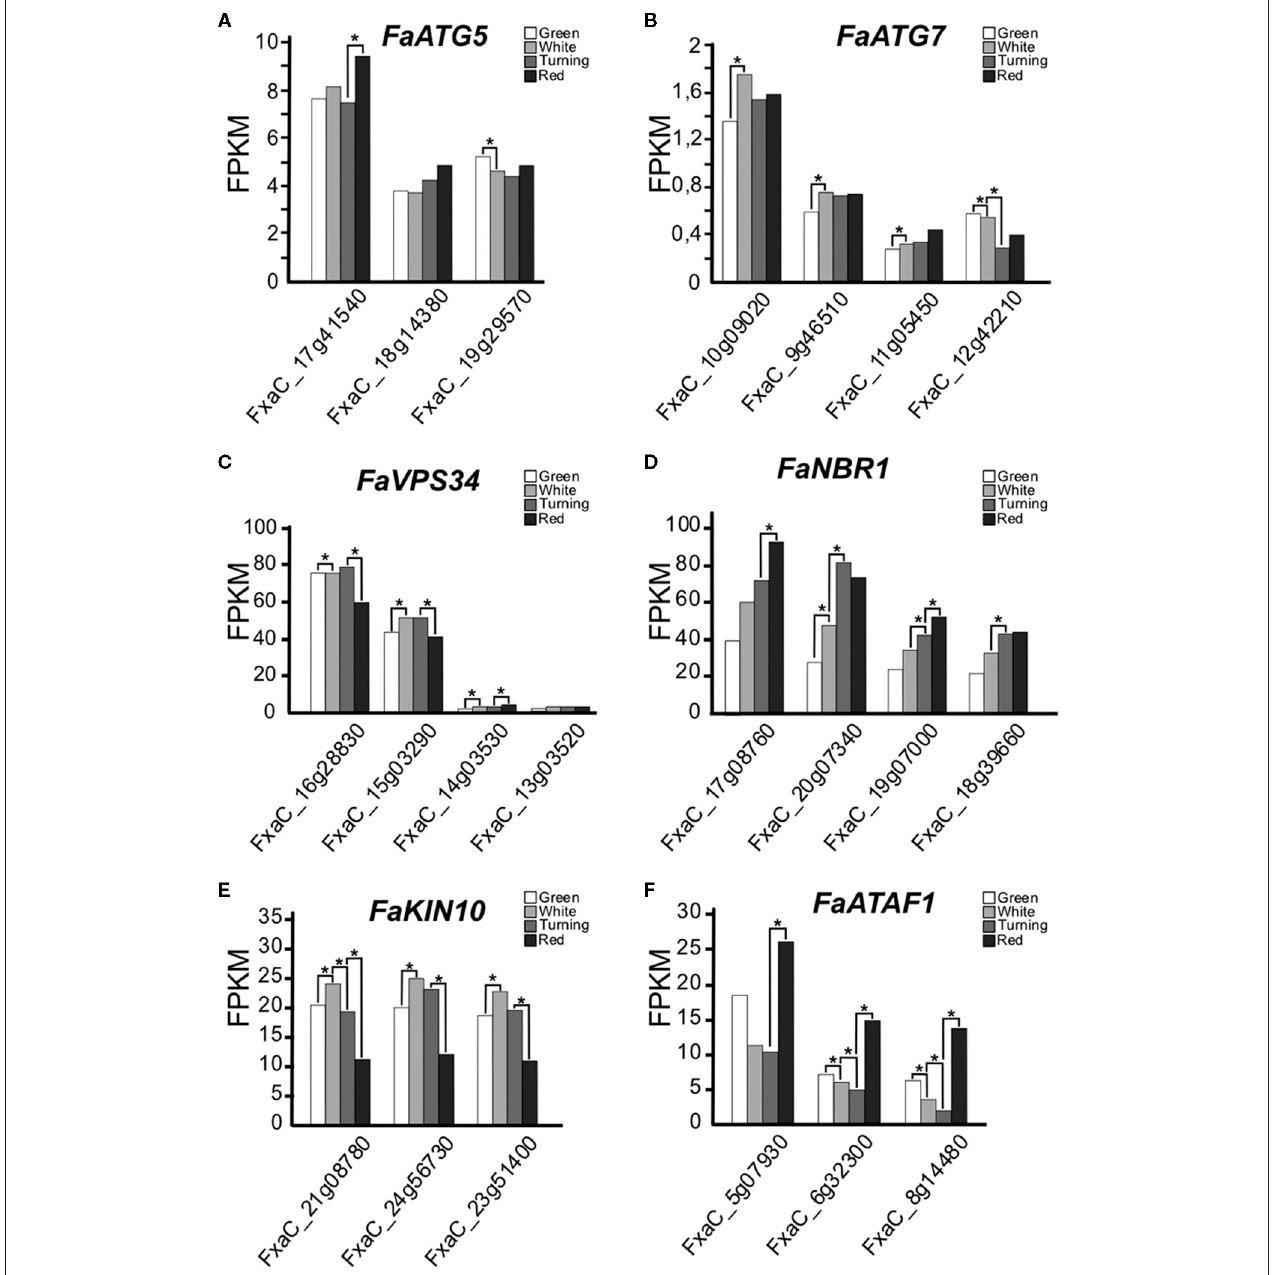
FIGURE 1 | (A–F) Expression of autophagy-related genes along ripening in F. x ananassa cv. Camarosa. Data for this analysis were extracted from the RNAseq generated by Sánchez-Sevilla et al. (2017). RNA was extracted from de-achene receptacles at the stages green, white, turning, and red. Statistical significance was determined between one stage and the next; it is indicated with an asterisk. Statistical analysis was performed with the false discovery rate (FDR) method after Benjamini-Hochberg correction for multiple-testing. Complete statistical analysis can be found in Supplementary Table 2 .